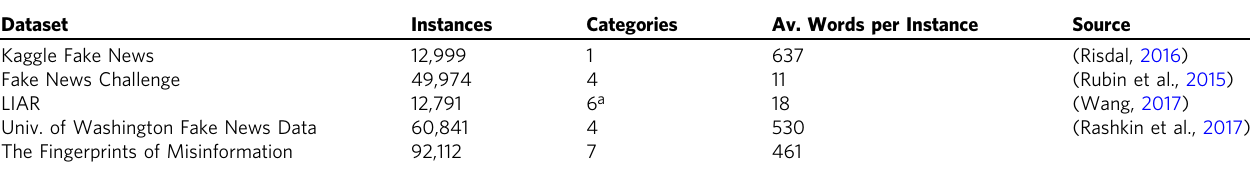
Table 2 Comparison with other datasets and